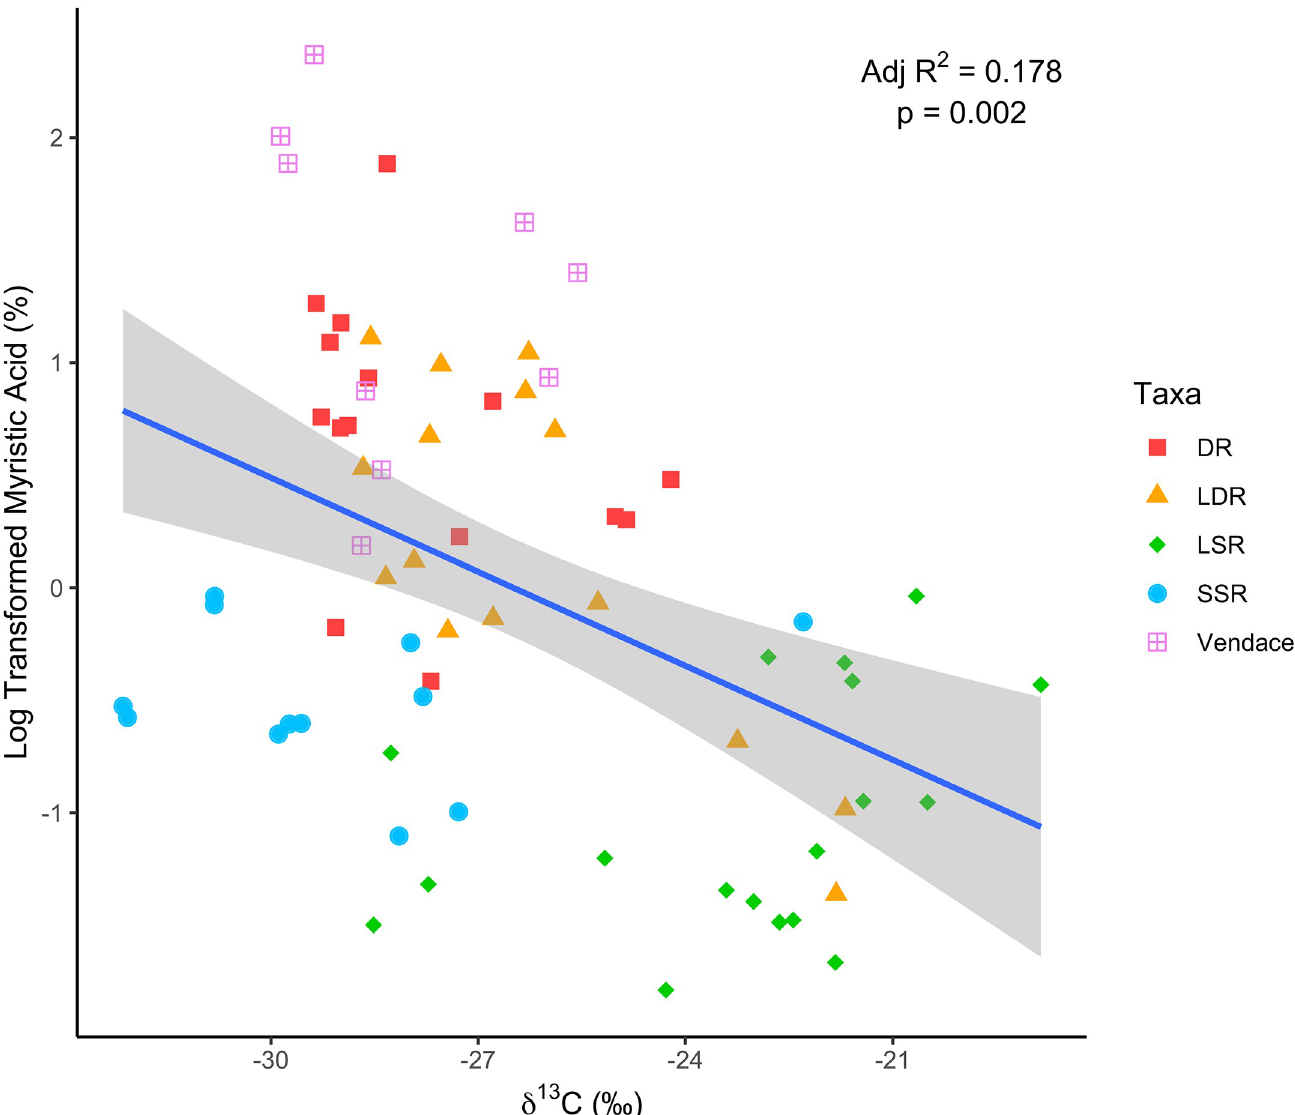
Fig 4. Relationship between log-transformed myristic acid concentration (%) and δ 13 C (‰) in coregonid taxa. DR = densely-rakered whitefish, LDR = large densely-rakered whitefish, LSR = large sparsely-rakered whitefish, SSR = small sparsely-rakered whitefish.